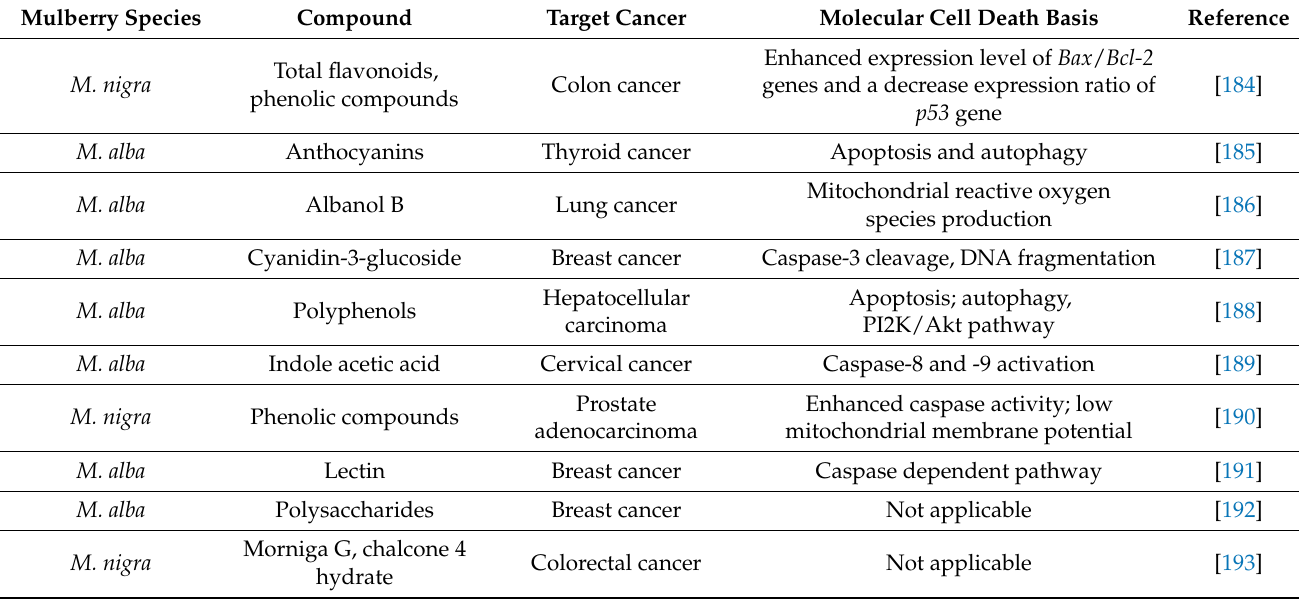
Table 5. The antitumoral activity of mulberry